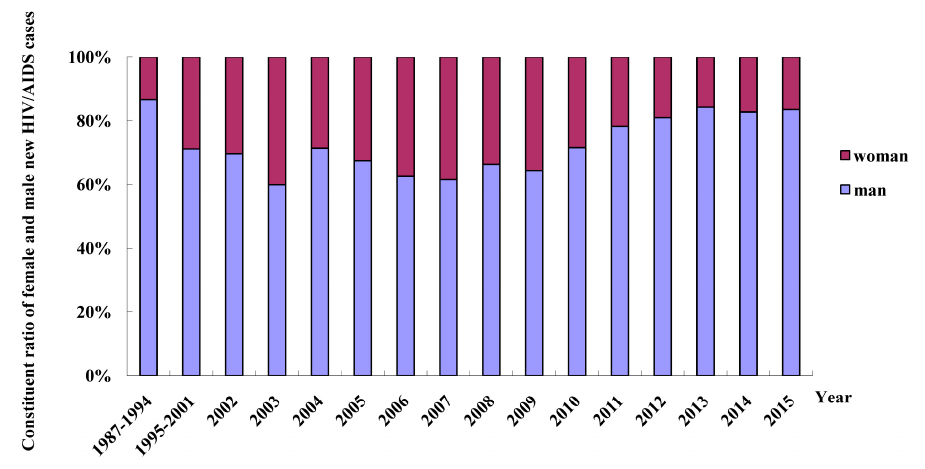
Figure 2. Gender-specific distribution of new HIV/AIDS patients reported in Fujian Province from 1987 to 2015.